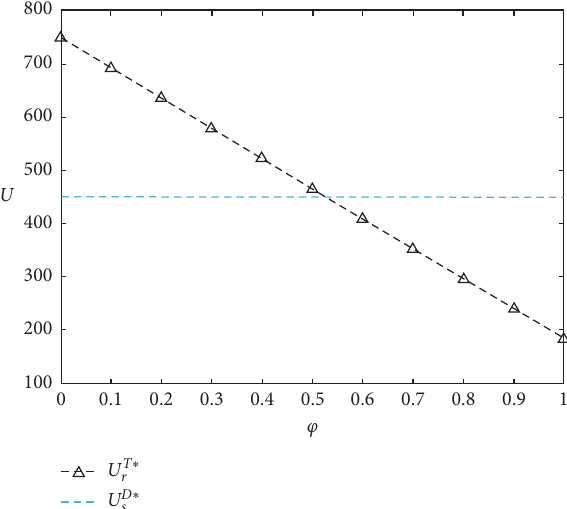
Figure 7: The effect of cost-sharing ratio on retailer utility.